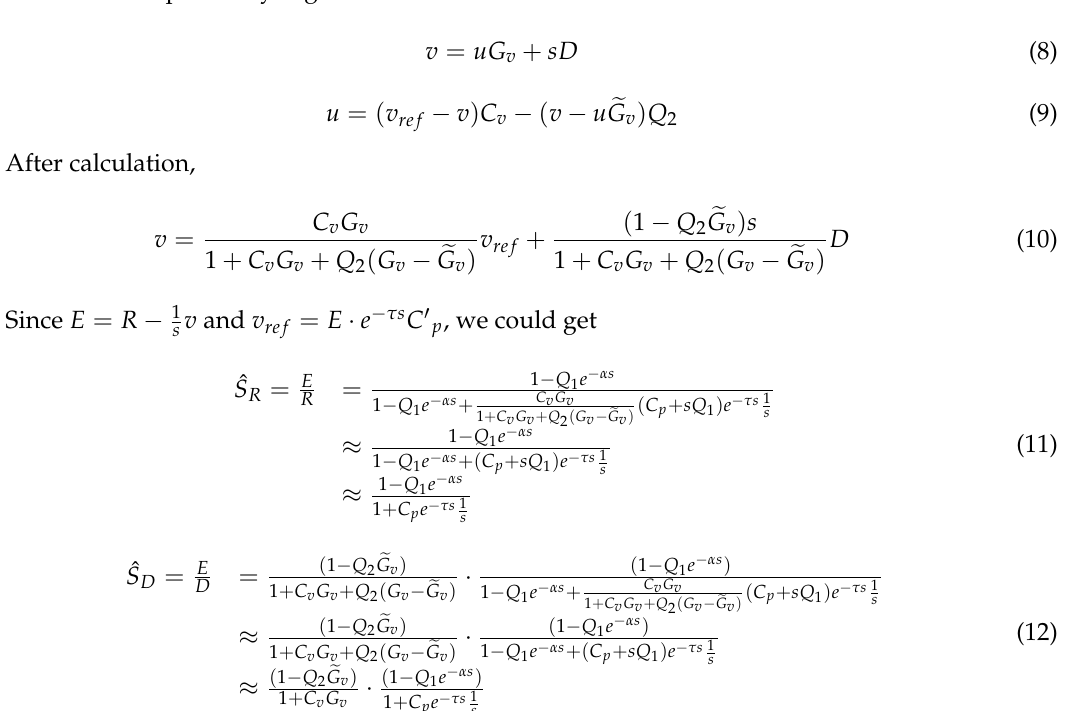
Figure 6. The VPDC structure enhanced by EOB and DOB. (cid:101) G v refers to the approximate velocity model of the platform and (cid:101) G v ≈ G v . Q 2 refers to the DOB model of the platform and